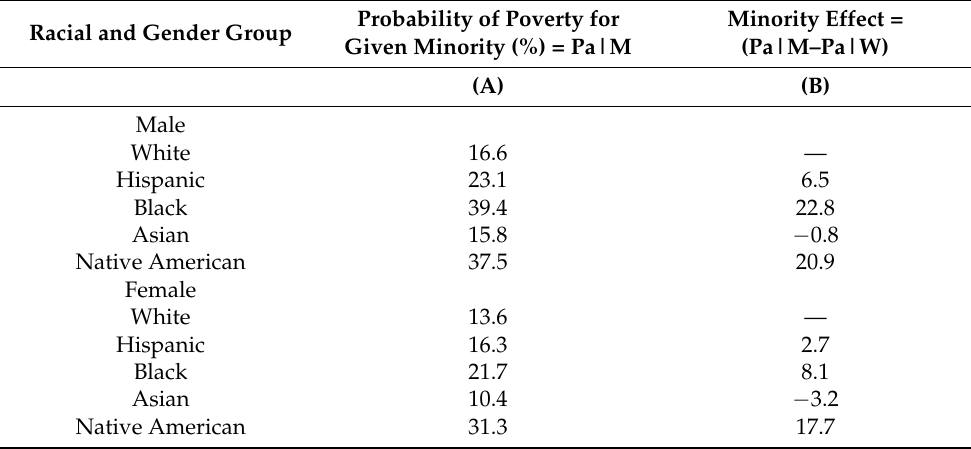
Table 3. Racial Minority Effects by Gender on Becoming a Poor Adult Derived from Results of Chetty et al.